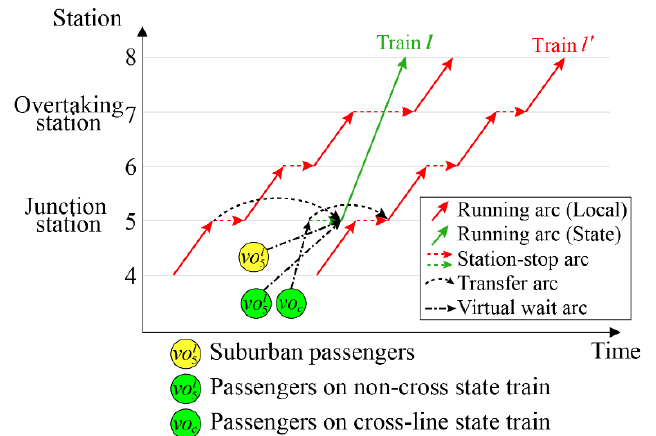
Figure 5. Different type waiting arcs of different origin nodes at the junction station.